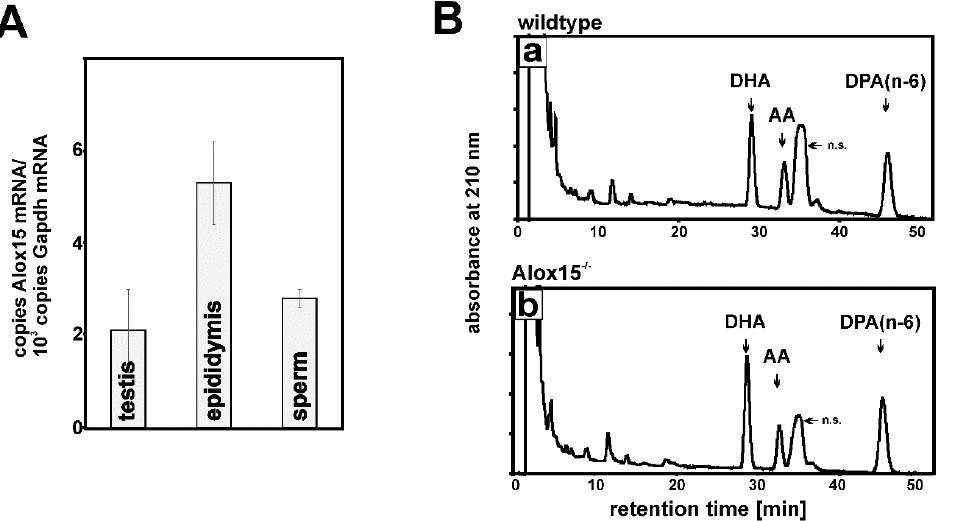
Figure 3. Expression of Alox15 in mouse wild-type sperm and characterization of the PUFA composition of sperm of different genotypes. ( A ) Quantitative RT-PCR of Alox15 in the testis, epididymis, and sperm of wild-type mice. Total RNA preparation and qRT-PCR were carried out as described in “Materials and Methods”. The Alox15 mRNA copy number/10 3 GAPDH mRNA copy number ratio was calculated to quantify the Alox15 expression level. ( B _ a ) RP-HPLC chromatogram of the hydrolyzed lipid extracts of wild-type sperm. Lipid extraction, alkaline hydrolysis, and HPLC analyses were carried out as described in the “Materials and Methods” section. PUFA peaks were identified by co-chromatography with commercial standards. ( B _ b ) RP-HPLC chromatogram of the hydrolyzed lipid extracts of Alox15 − / − sperm. N = 12 animals of each genotype were analyzed. Statistical evaluation showed no significant differences in the relative content of the analyzed main PUFAs of sperm (Figure S2). DHA: docosahexaenoic acid, AA: arachidonic acid, DPA: docosapentaenoic acid, n.s.: no specific fatty acid.